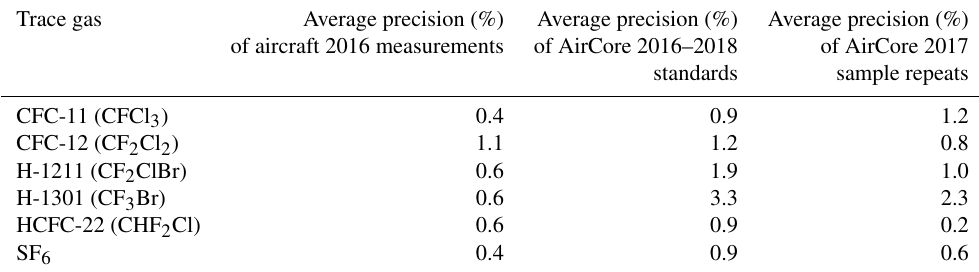
Table 1. Comparison of average measurement uncertainties (derived as the average of 1 standard deviation from repeated working standard or air sample measurements) of the research aircraft campaign in 2016; all AirCore flights; and some AirCore sample repeats for CFC-11, CFC-12, H-1211, H-1301, HCFC-22, and SF 6 . For AirCore uncertainties, the average working standard uncertainty over 3 years was used as it is (a) more representative of the entire measurement period and (b) generally comparable or worse than precisions derived from sample repeats. AirCore-based precisions are generally slightly worse than those achieved with the larger aircraft-based samples but still much smaller than mixing ratio gradients observed in the